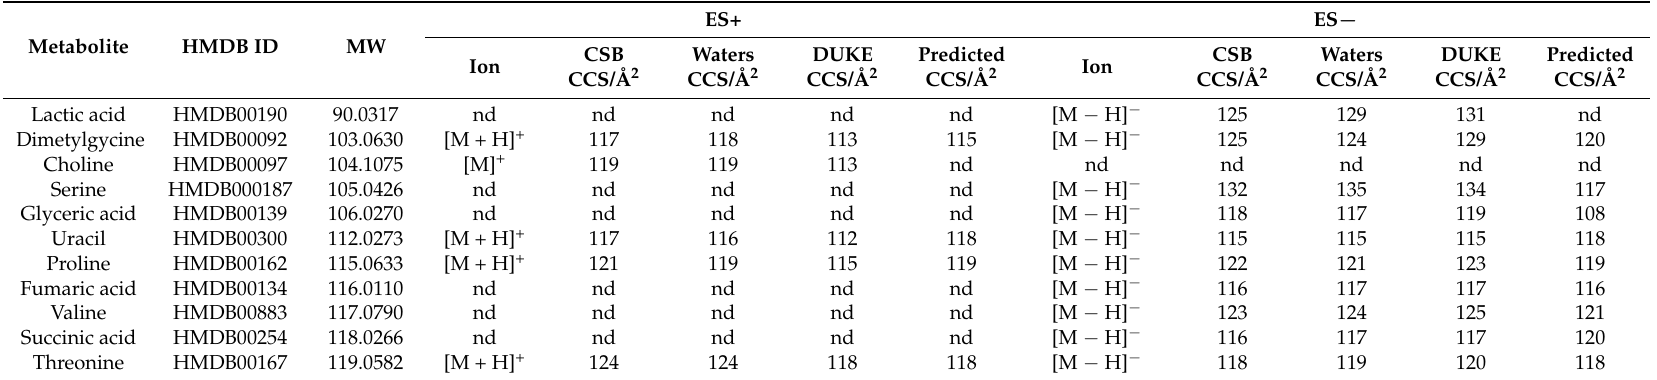
Table 6. An inter-laboratory reproducibility dataset containing experimental and predicted CCS values. CSB, Waters and Duke represent three independent laboratories where LC-IMS experiments were conducted. Reproduced with permission from [73]. Copyright American Chemical Society,